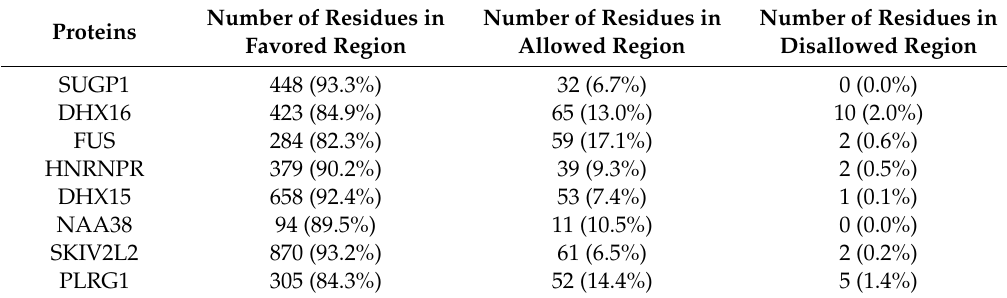
Figure 5. Ramachandran plot of the selected homology modeled 3D protein structures of hub genes. The di ff erent colored areas show ‘disallowed’ (beige), ‘generously allowed’ (yellow) and ‘most favored’ (red) regions. Table 5. Ramachandran plot